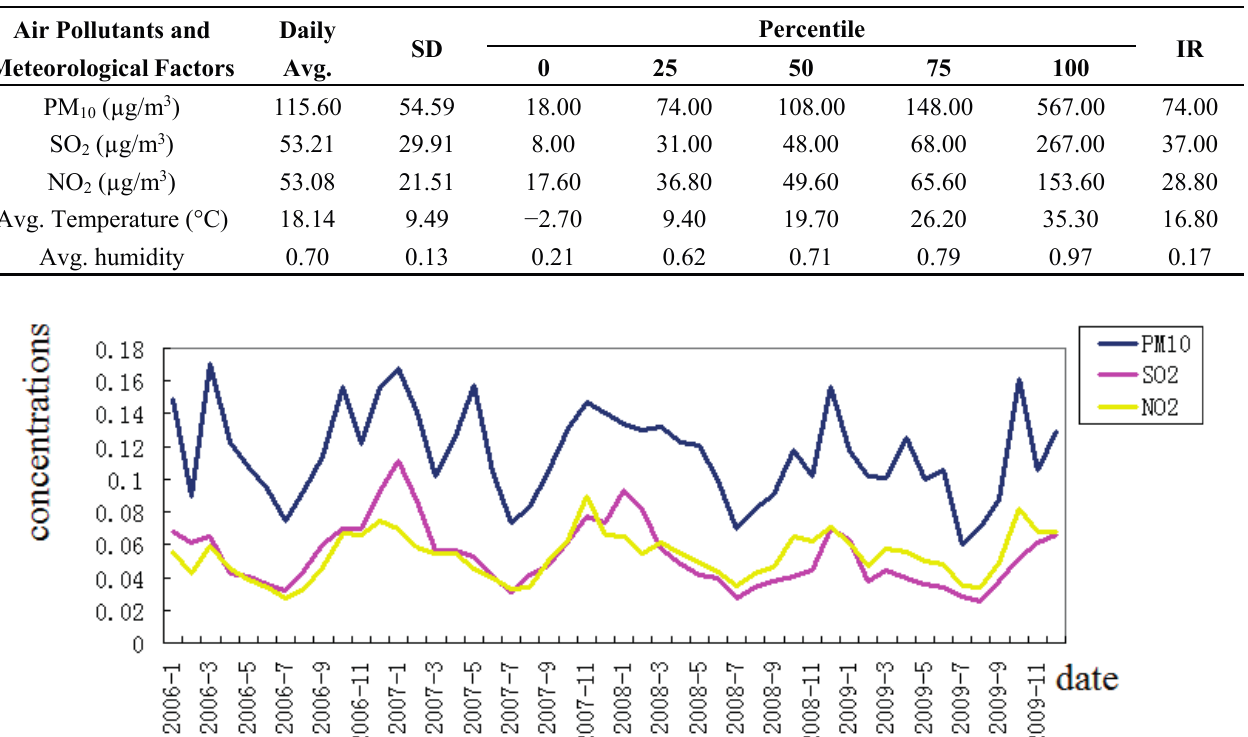
Table 2. Descriptive analysis of air pollutants and meteorological factors in Wuhan, 2006–2009.